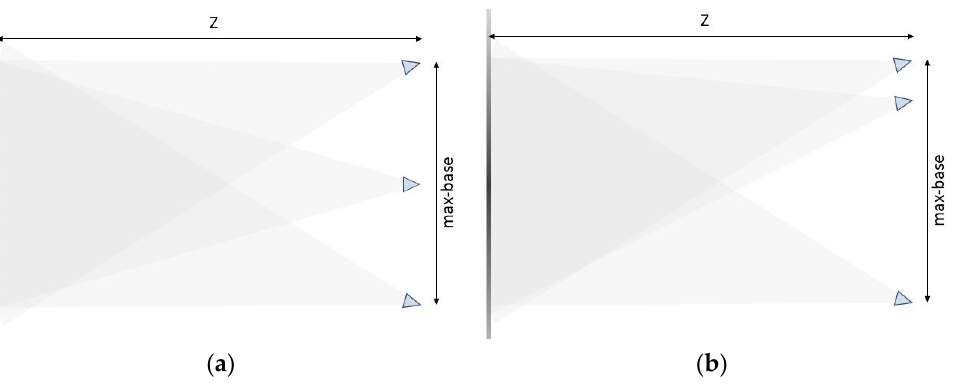
Figure 10. Examples of ( a ) symmetrical and ( b ) asymmetrical geometry of image acquisition referred to M3.